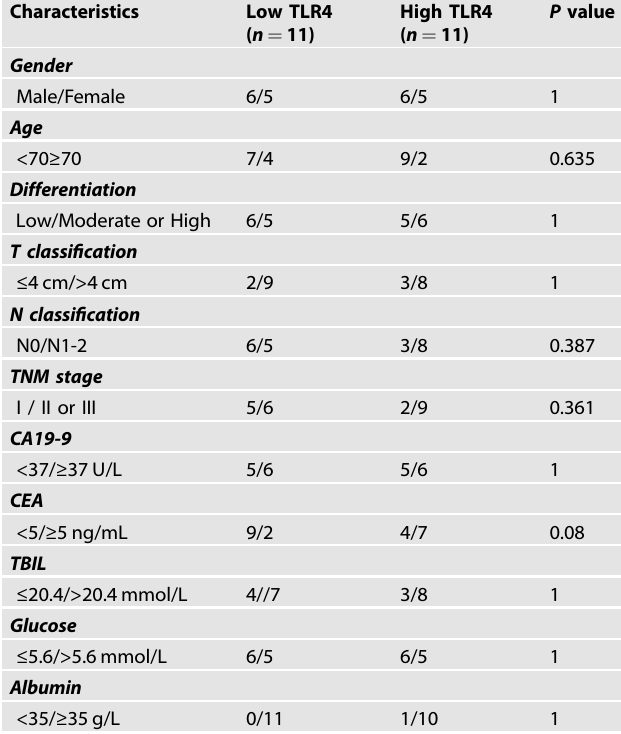
Table 1. The relationship between tumoral TLR4 expression and clinicopathological characteristics in resected PDAC